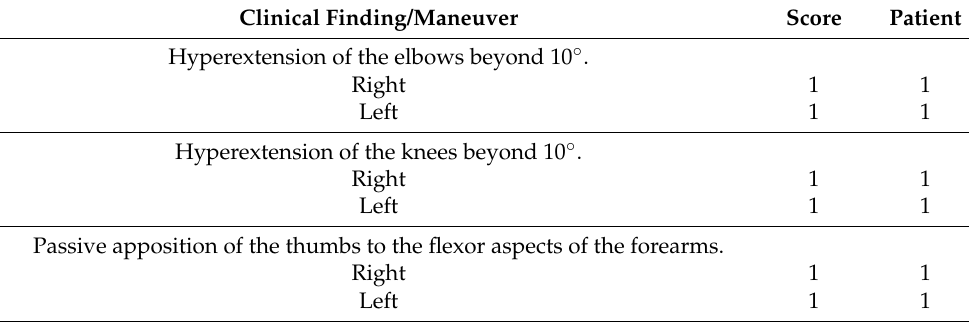
Table 1. The Beighton Hypermobility Score. Clinical Finding/Maneuver Score Patient Hyperextension of the elbows beyond 10 ◦